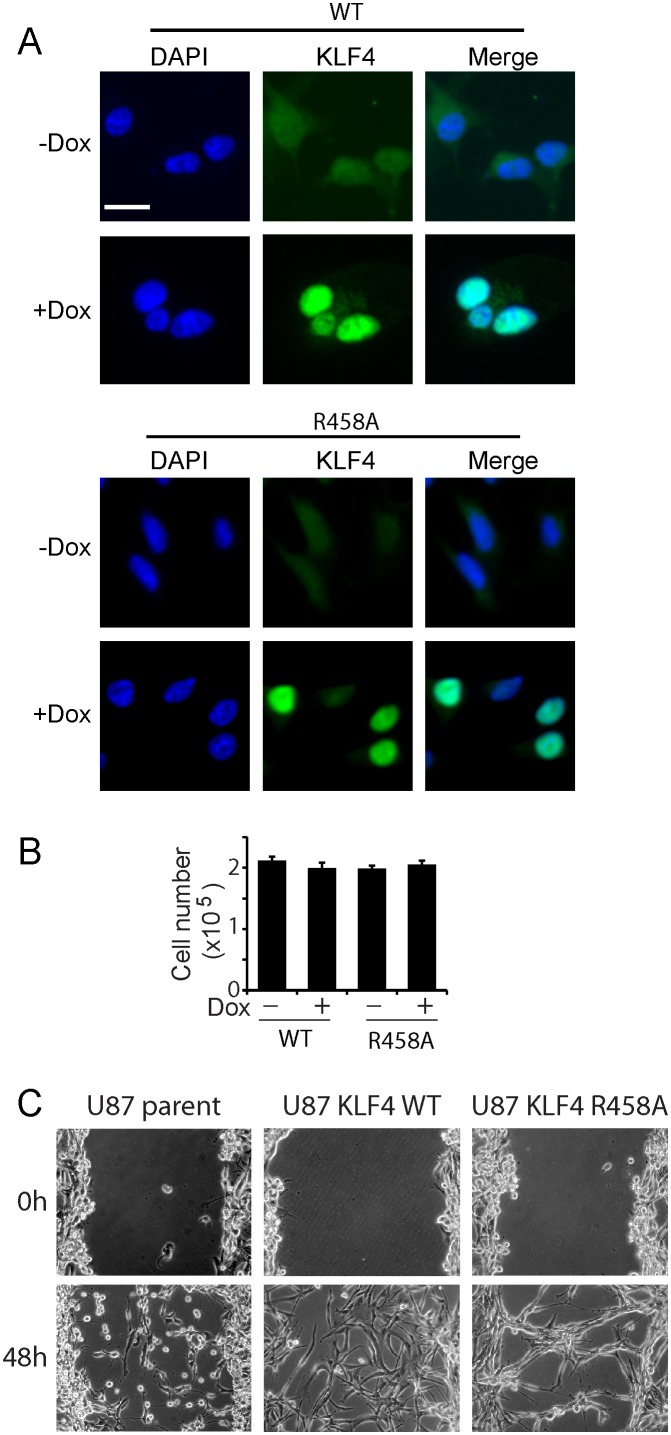
Expression of KLF4 WT and R458A mutant did not affect cell growth.(A) Immunocytochemistry staining of KLF4 cellular location. Human U87 GBM cells express low level of endogenous KLF4 protein, which was evenly spread in cytoplasma and nucleus. Dox induction of KLF4 WT and R458A expression resulted in strong KLF4 staining in the nucleus. Bar = 10 µm. (B) KLF4 WT and R458A had no effect on cell growth 5 days post Dox (1 µg/ml) treatment as determined by trypan blue staining. (C) Scratch assays for 48 hr in KLF4 WT expressing cells (+Dox) in comparison with non-transfected U87 parent cells and KLF4 R458A expressing cells. Bar = 25 µm.